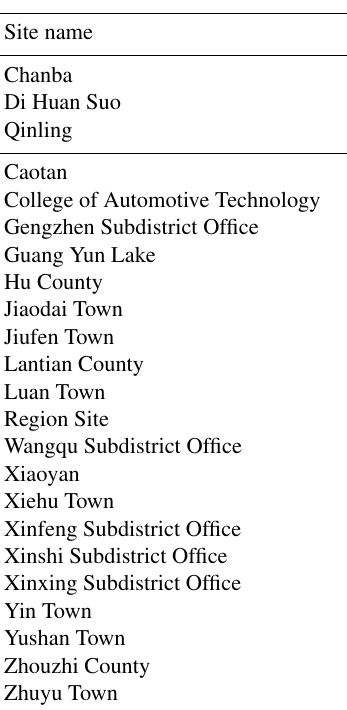
Table 1. Detailed sampling site